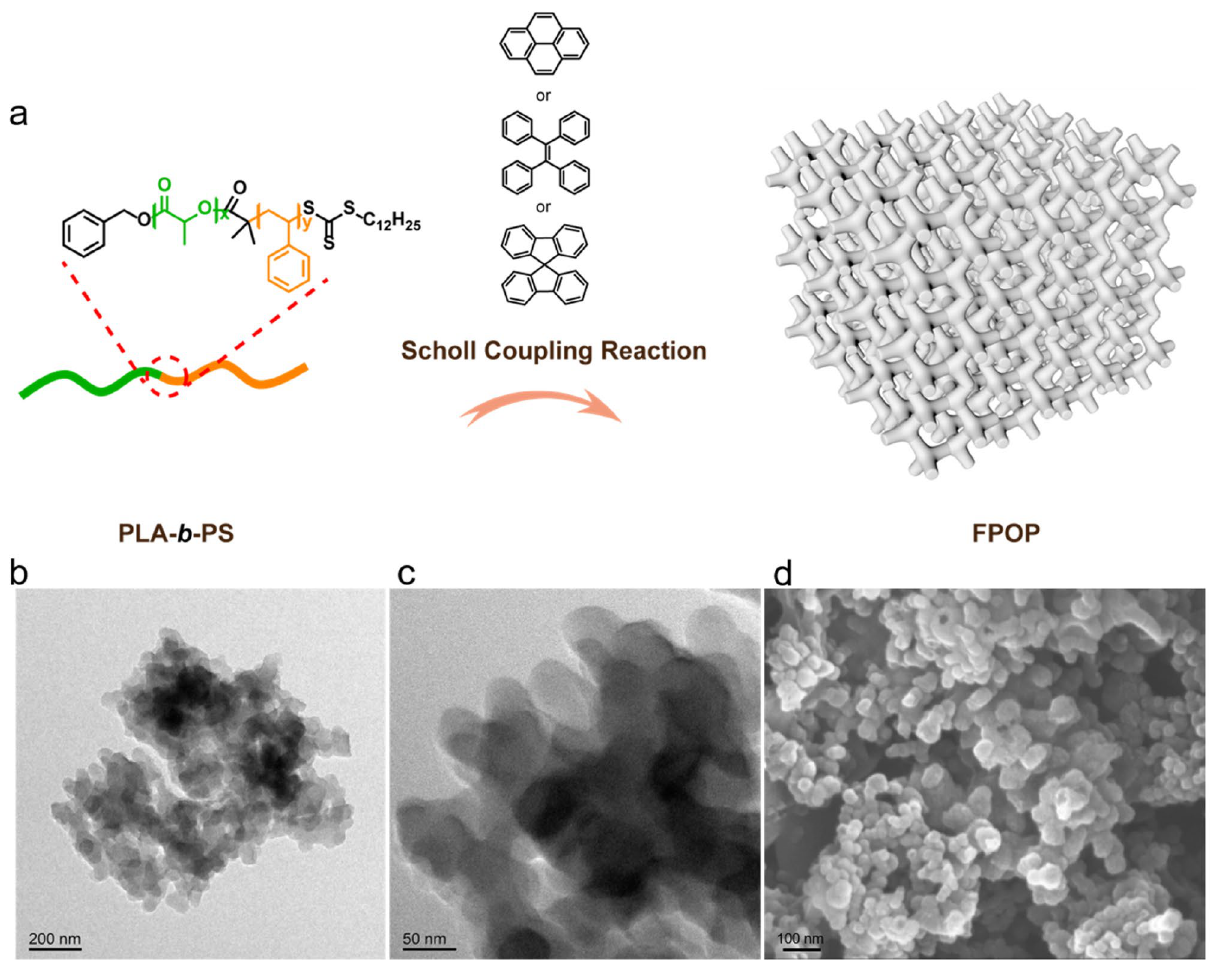
Figure 1. Synthesis and characterization of FPOP-TPE. ( a ) Schematic illustration of the preparation of FPOP- TPE. ( b, c ) Typical TEM images in a different magnification of FPOP-TPE. ( d ) SEM image of